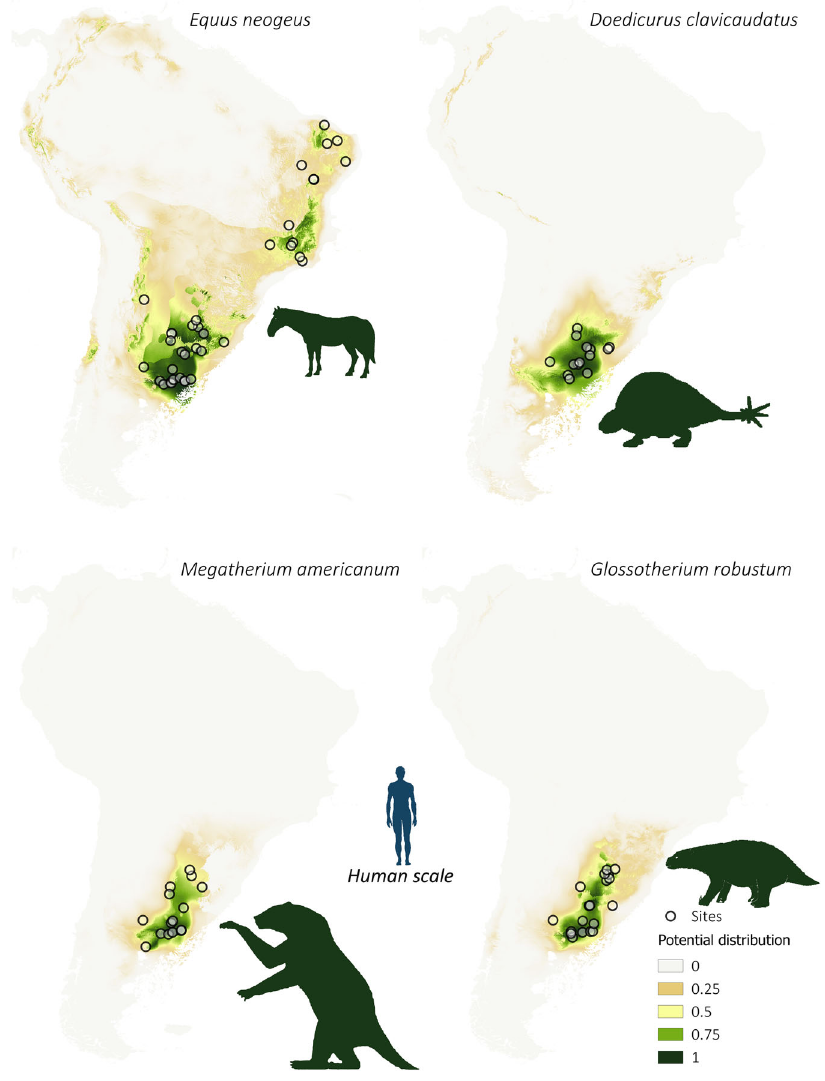
Fig. 4 Spatial distribution of Pampean megafaunal species. Potential distribution maps of Equus neogeus , Doedicurus clavicaudatus , Megatherium americanum , and Glossotherium robustum during the late Pleistocene – early Holocene (18 k – 9 k cal BP). Values of potential distribution vary from 0 (light beige) to 1 (dark green). Empty dots represent species occurrence